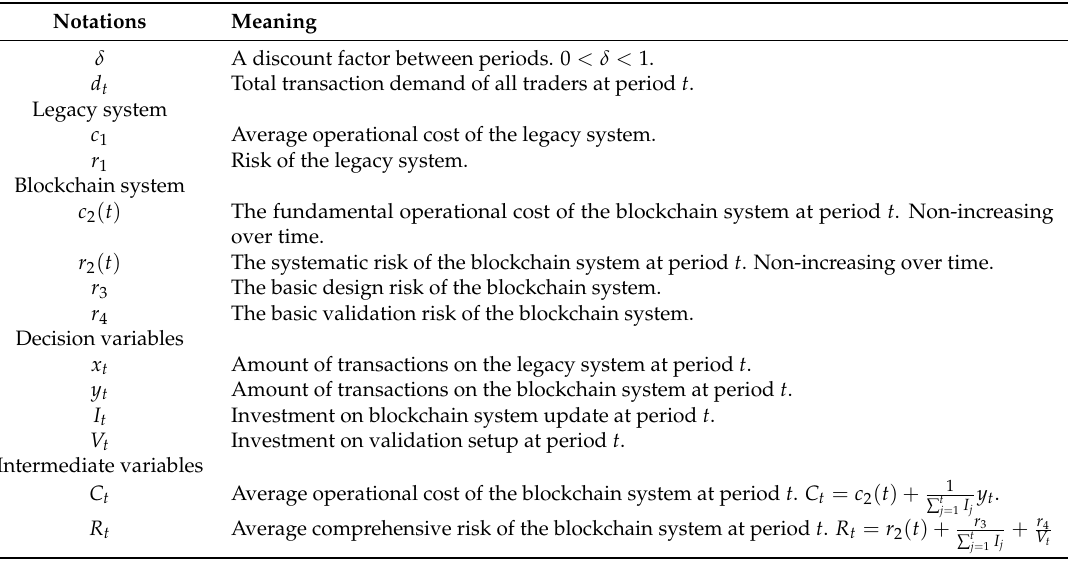
Table 3 summarizes parameters and variables of the organizer’s model. Table 3. Notations of variables and parameters of the organizer’s